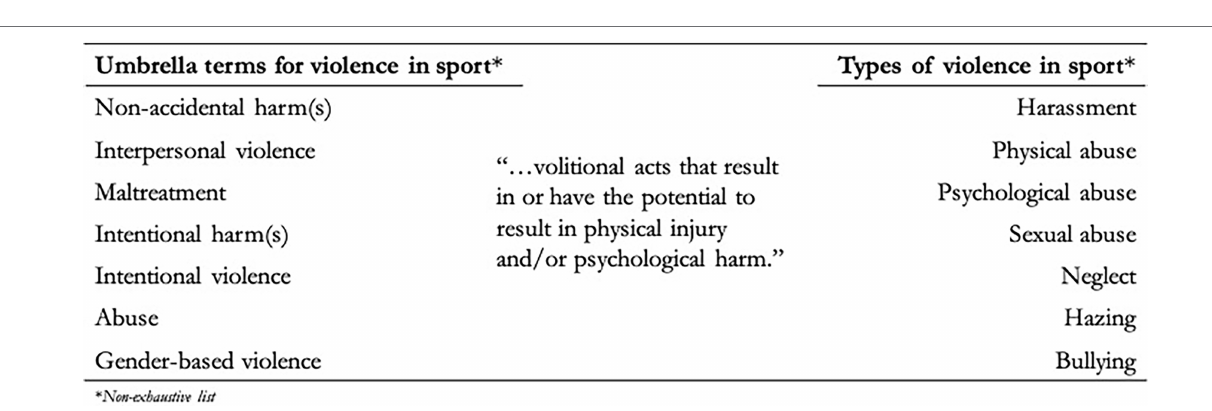
FIGURE 2 | Terminology of harassment and abuse sportspeople may